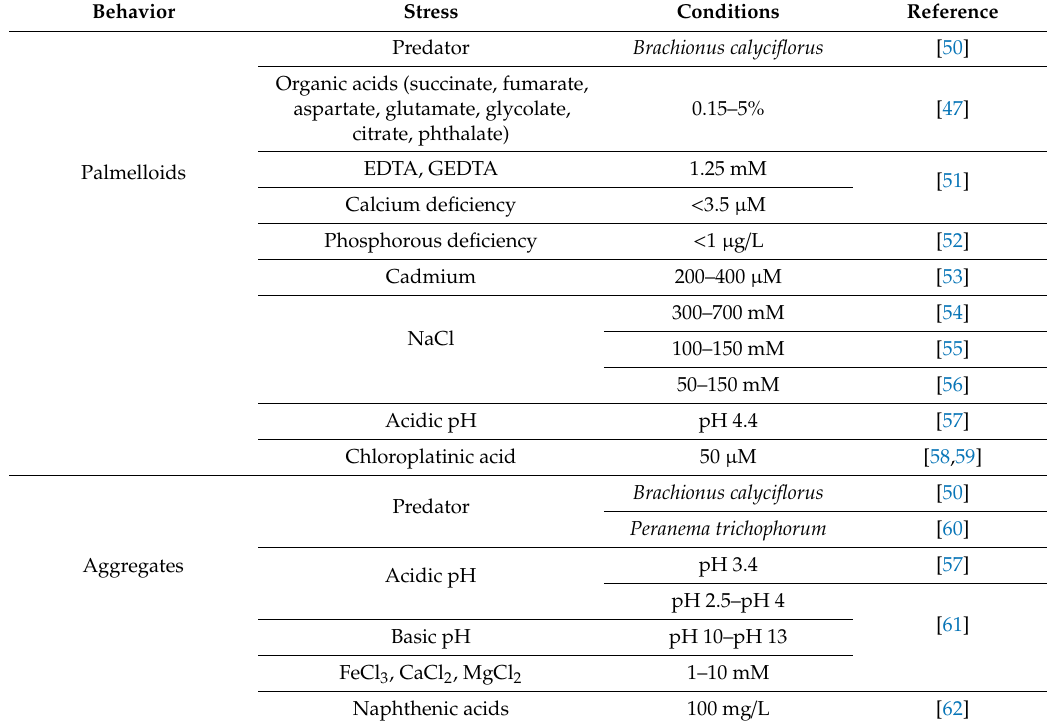
Table 1. Multicellular structure formation in response to stress in Chlamydomonas . In response to di ff erent types of biotic or abiotic stresses and depending on their intensity, Chlamydomonas can form palmelloids or aggregates, suggesting that socialization may be a conserved mechanism that help algal cells adapt to harsh environmental